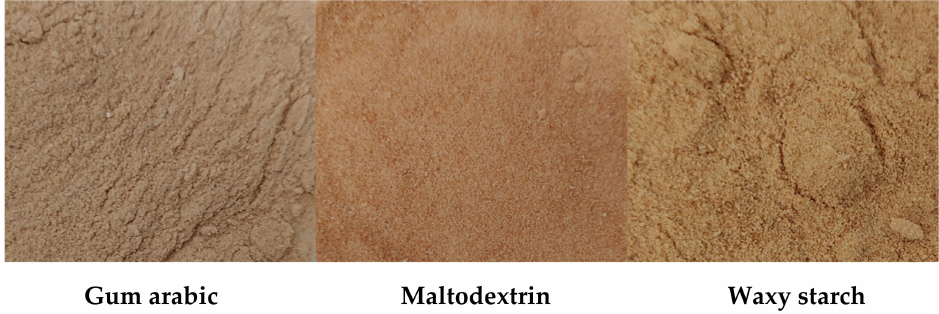
Figure 1. Colour of freeze-dried passion fruit peel powders developed using different carriers.